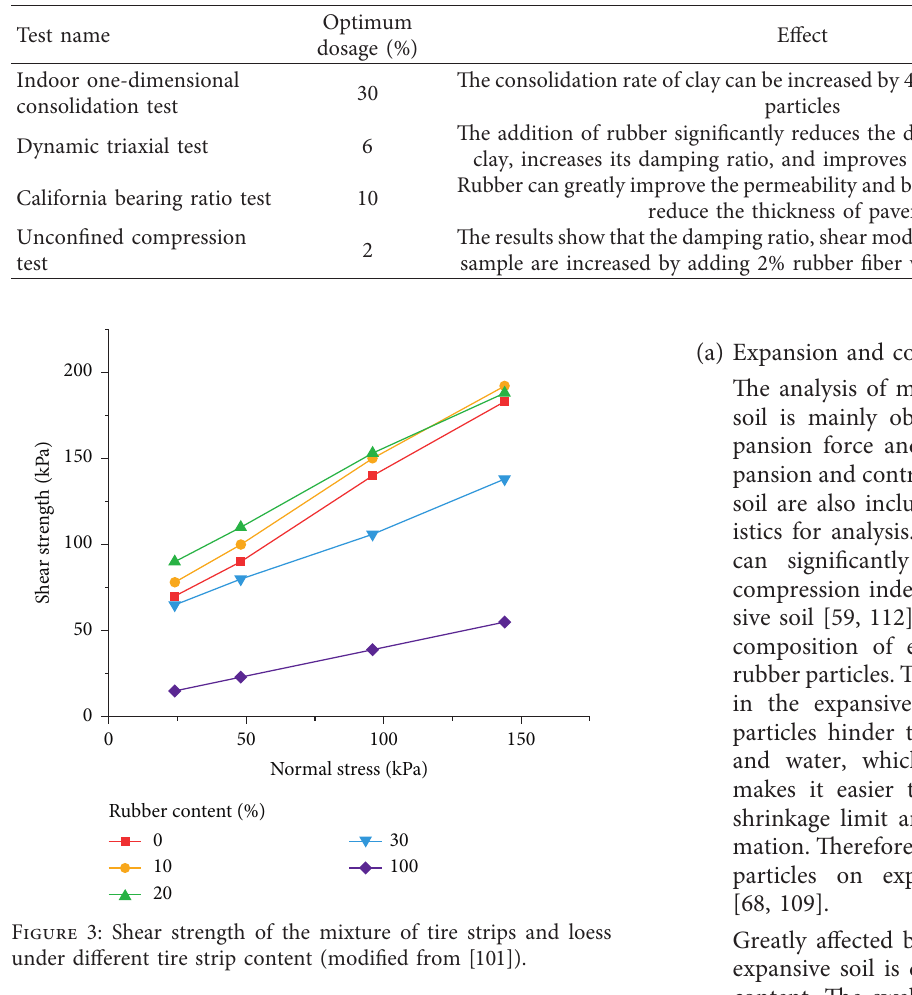
Table 6: Reinforcing effect of rubber on clay.